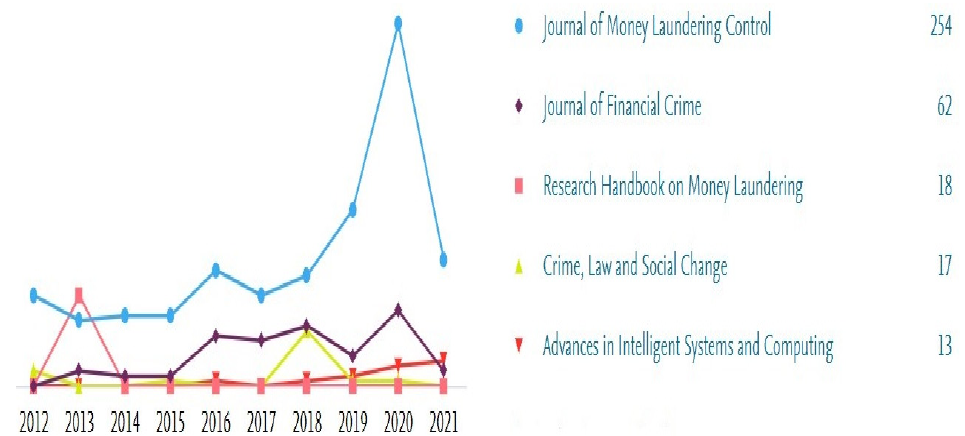
Figure 4. Top five Scopus sources, 2012 to 2021.